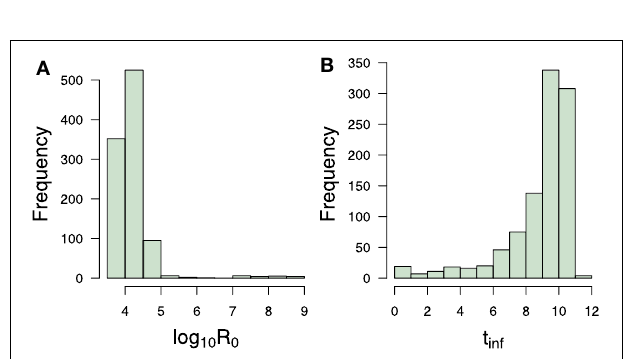
FIGURE 8 | Transmission measures. Bootstrap estimate of (A) reproductive number and (B) infecting time in hours. Numerical values can be found in Table 1